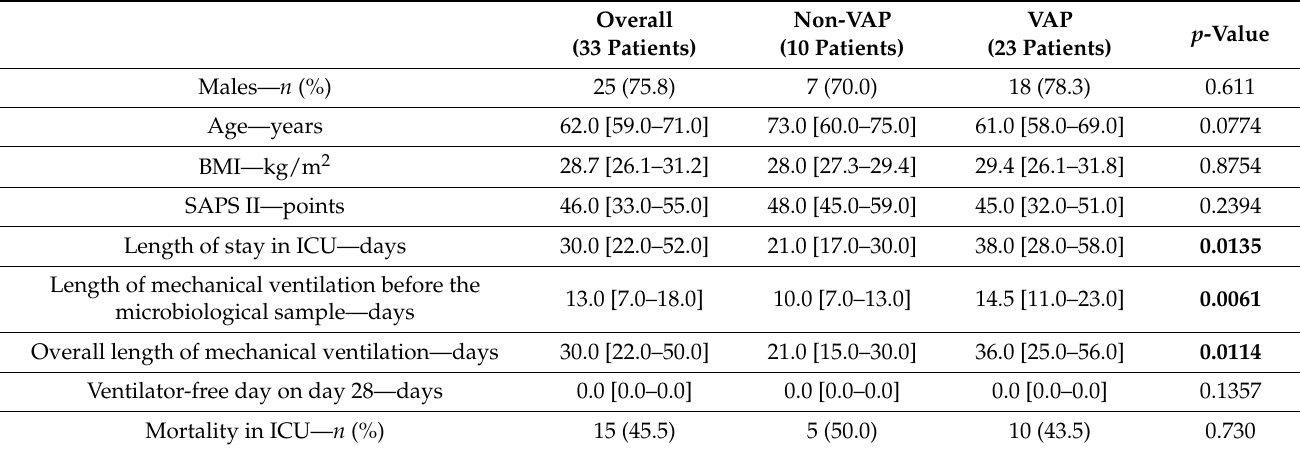
Table 1. Characteristics of the enrolled population of patients.